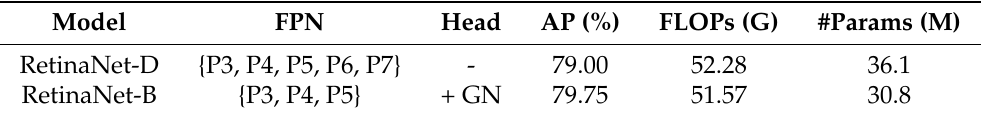
Table 2. Results of different RetinaNet architecture on GF1-LRSD. RetinaNet-D and RetinaNet-B denote the default network and the improved network, respectively. ‘Head’ means the detection subnet, including regression and classification branches.